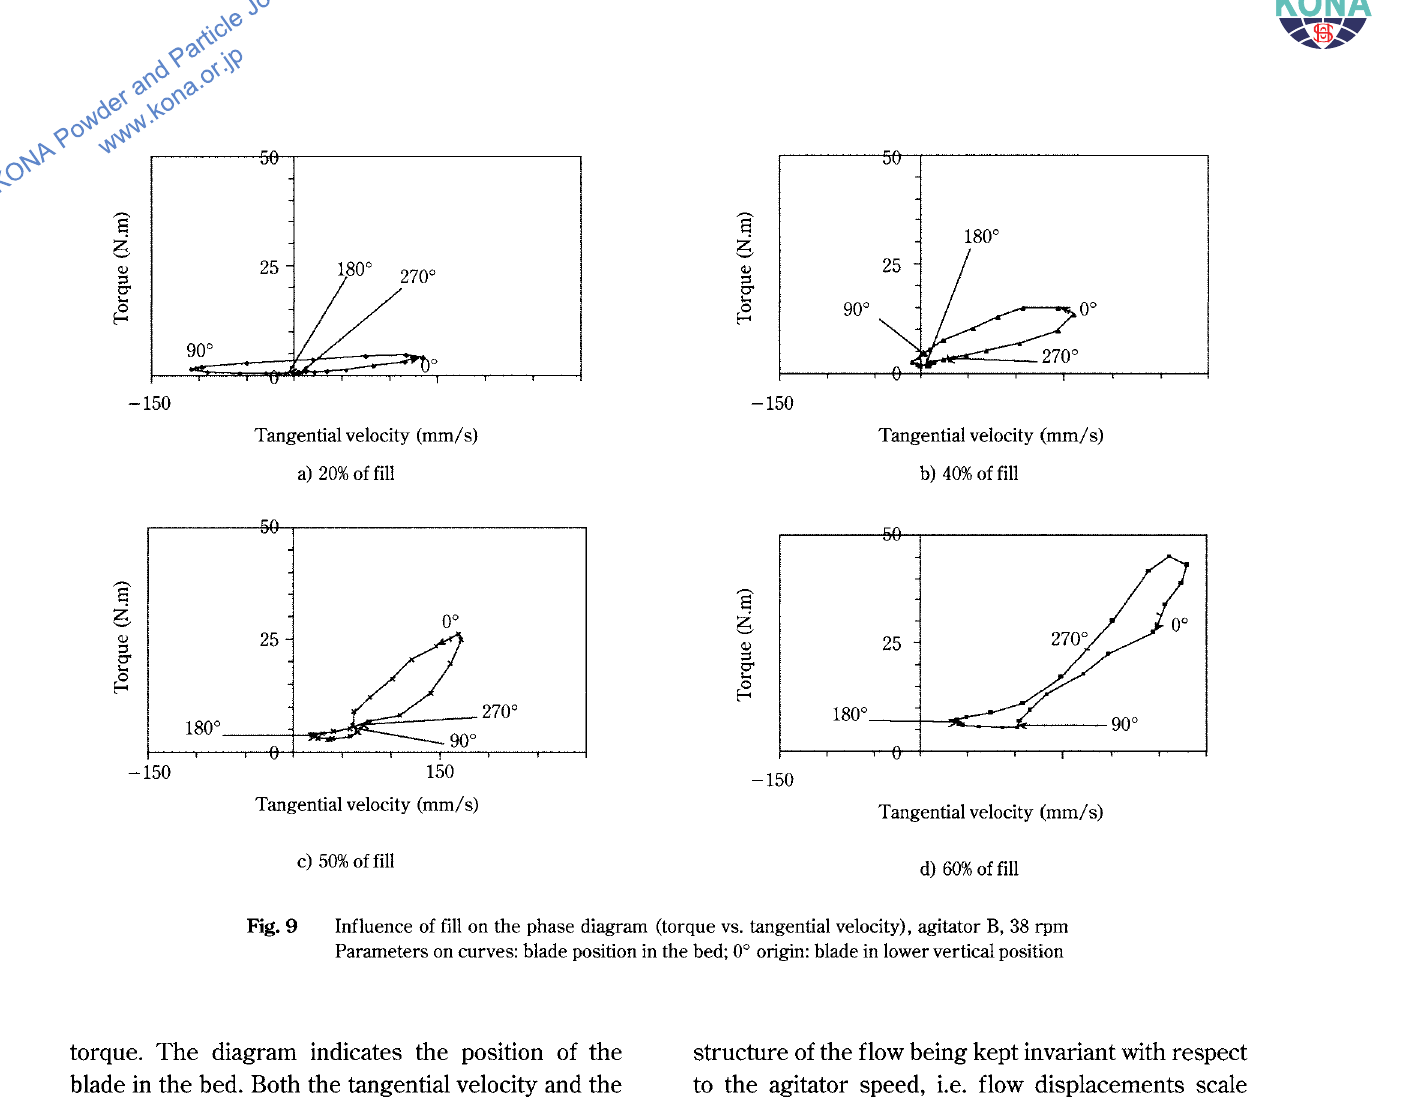
Influence of fill on the phase diagram (torque vs. tangential velocity), agitator B, 38 rpm Parameters on curves: blade position in the bed; 0° origin: blade in lower vertical